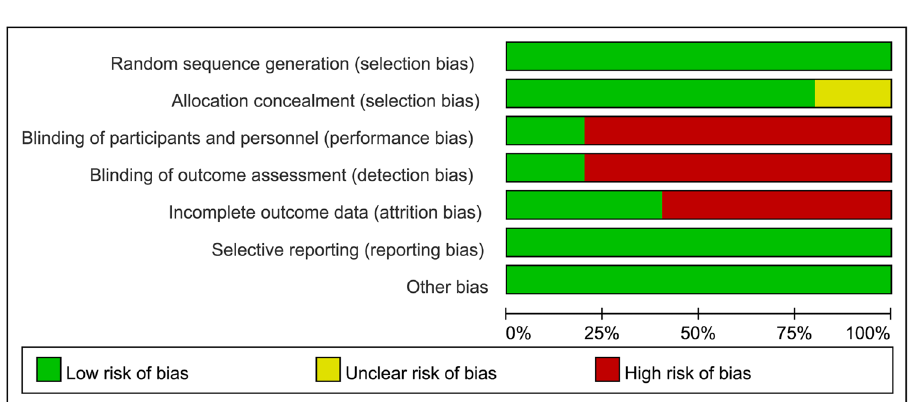
Figure 3. Overall risks of bias of the included